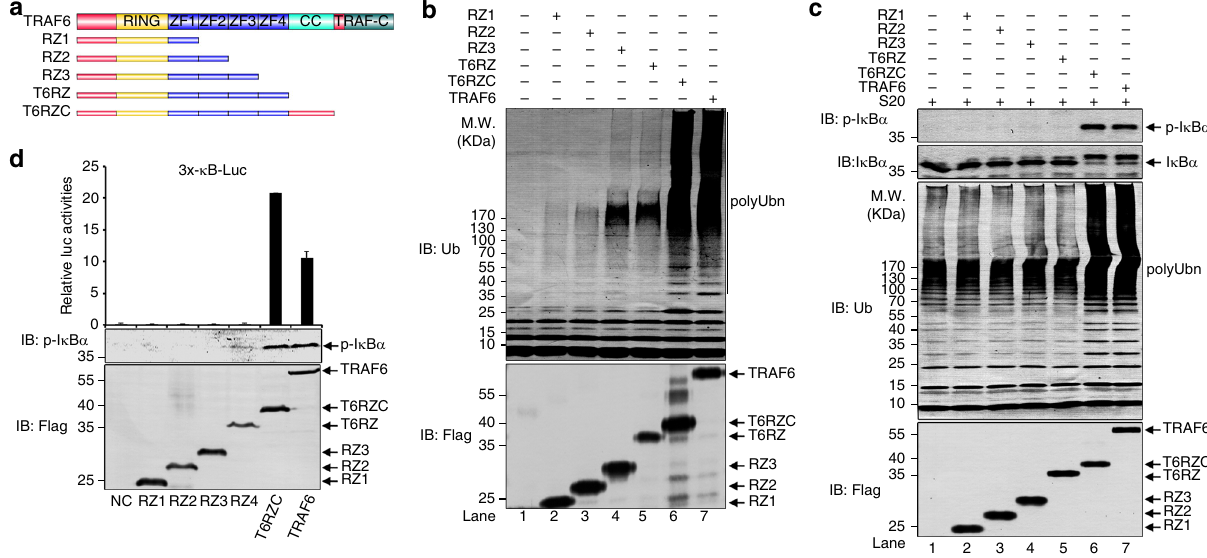
Fig. 2 CC domain of TRAF6 is essential for long polyubiquitin chain synthesis. a Schematic diagram of FL TRAF6 and its truncation mutants used in this study. b Only FL TRAF6 and T6RZC catalyze synthesis of long polyUb chains. Flag-tagged TRAF6 or the truncation mutants were transiently expressed in HEK293T/TRAF6 KO cells and puri fi ed by using anti-Flag M2 magnetic beads (Sigma), which were then used in the ubiquitination assays. The reaction products were immunoblotted with the indicated antibodies. c CC domain is required for TRAF6-stimulated IKK activation in vitro. In vitro IKK activation assay was carried out with TRAF6 and its mutants puri fi ed as in b . The reaction products were immunoblotted with the indicated antibodies to determine activation of IKK (phosphorylation of I κ B α ) and synthesis of polyUb chains. d CC domain is required for NF- κ B activation by TRAF6 in cells. TRAF6 or